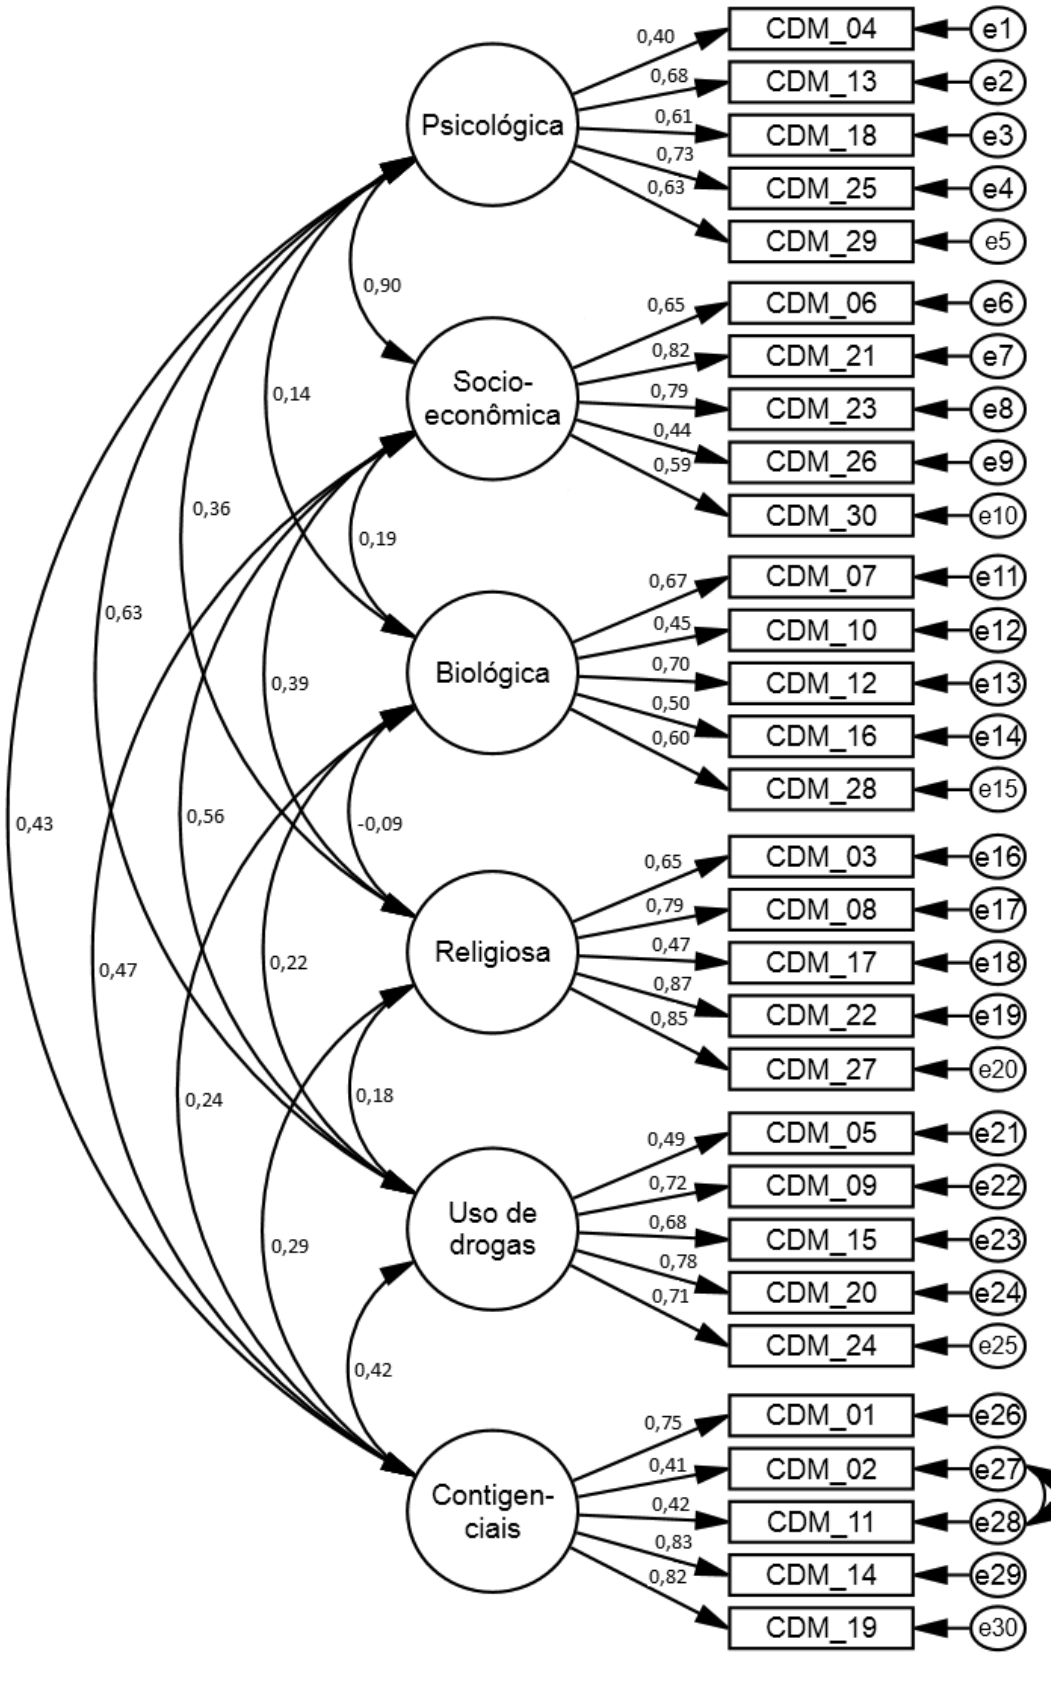
Figura 1 . Estrutura fatorial do modelo com seis fatores e suas